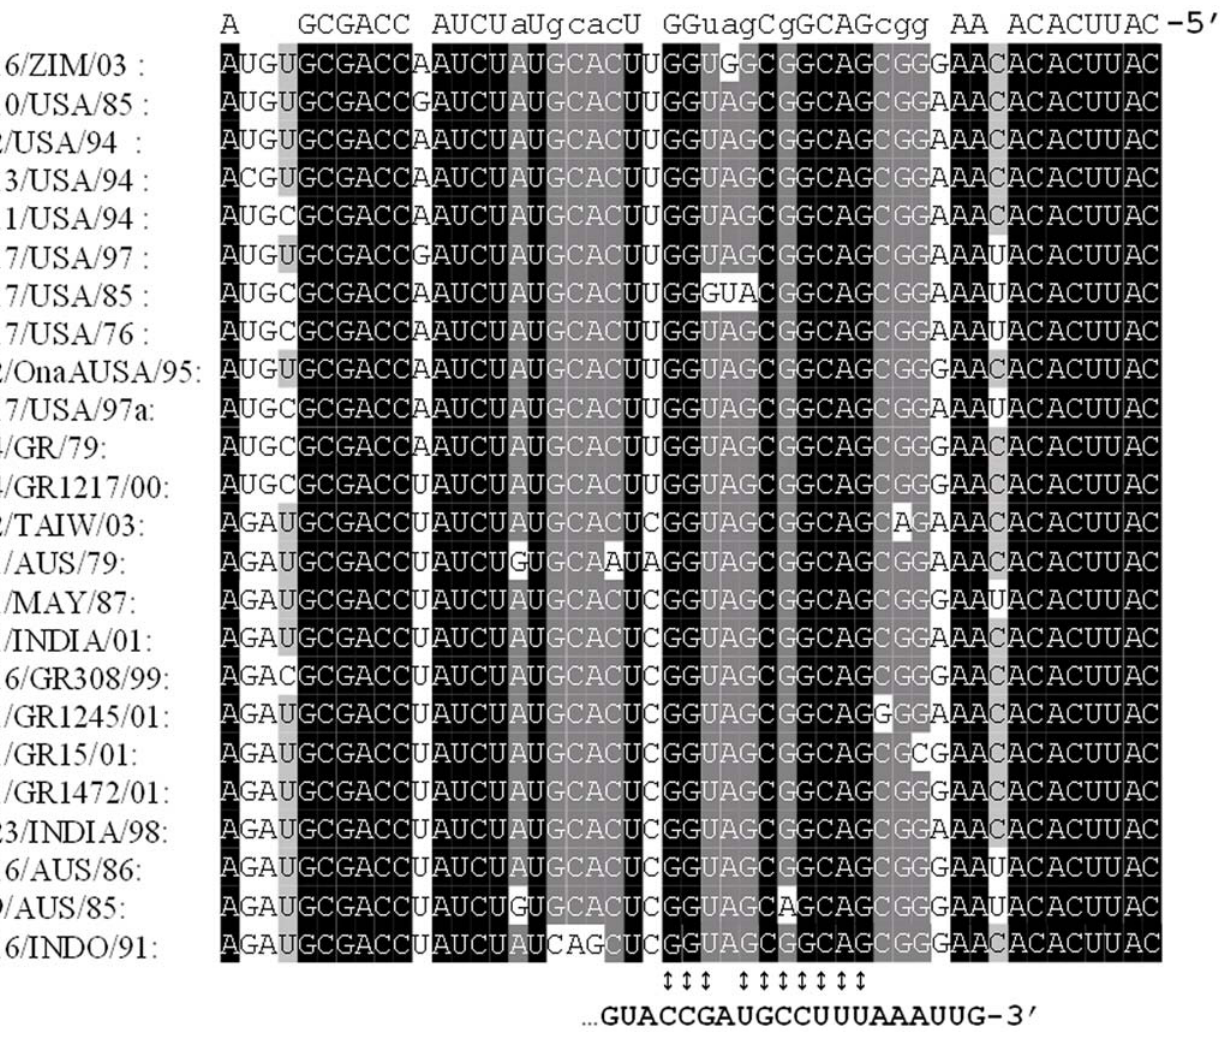
Figure 4. Sequence alignment of the 5 9 terminal NCRs determined, indicating base pairing with the 3 9 ends of the RNA transcripts. Only divergent sequences are shown.